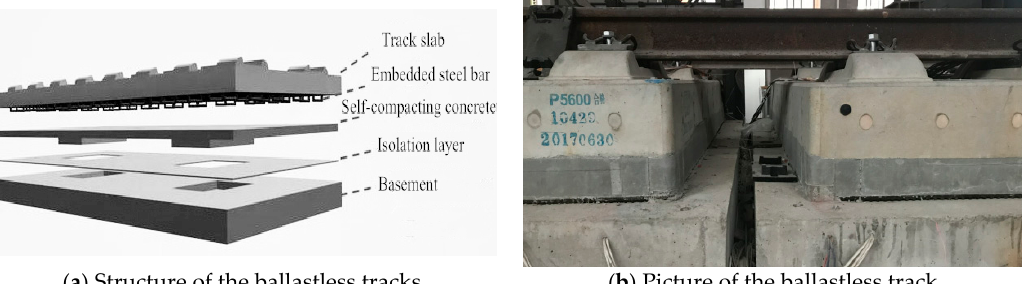
Figure 2. CRTS III slab ballastless track: ( a ) structure, ( b ) picture.